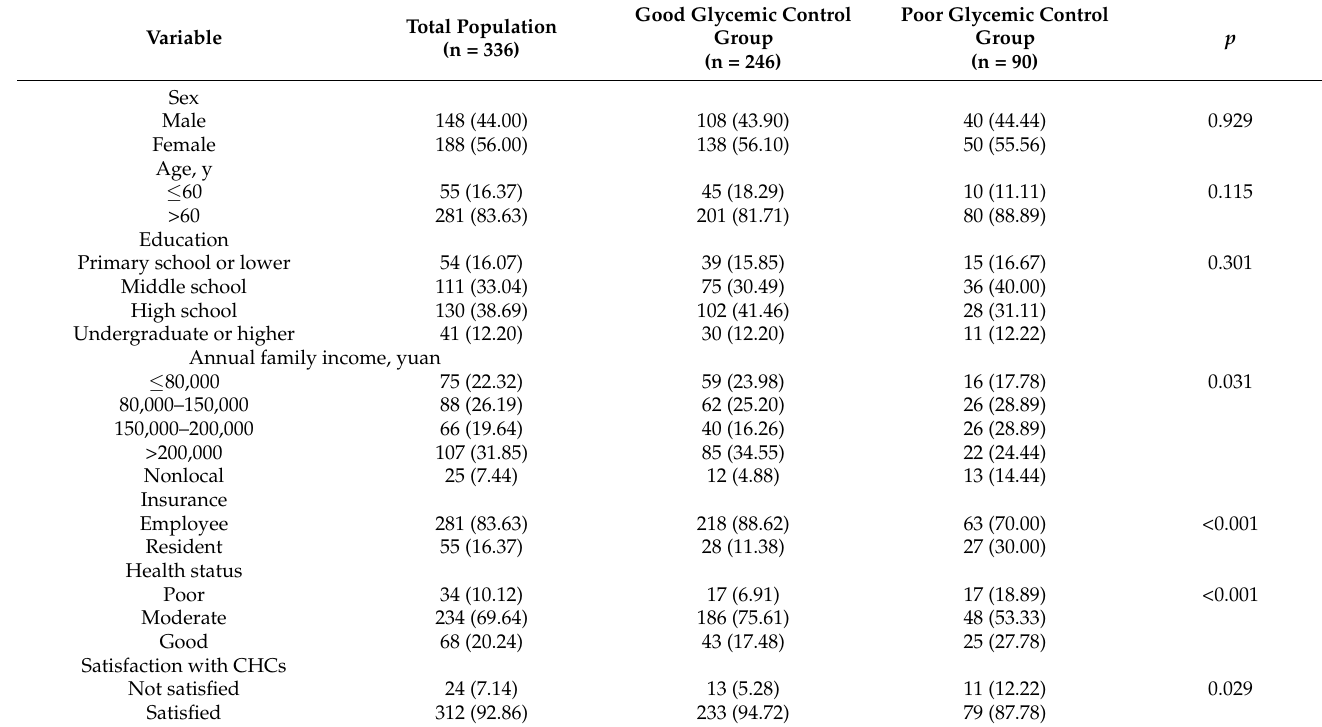
Table 1. Baseline characteristics of the study population (n =